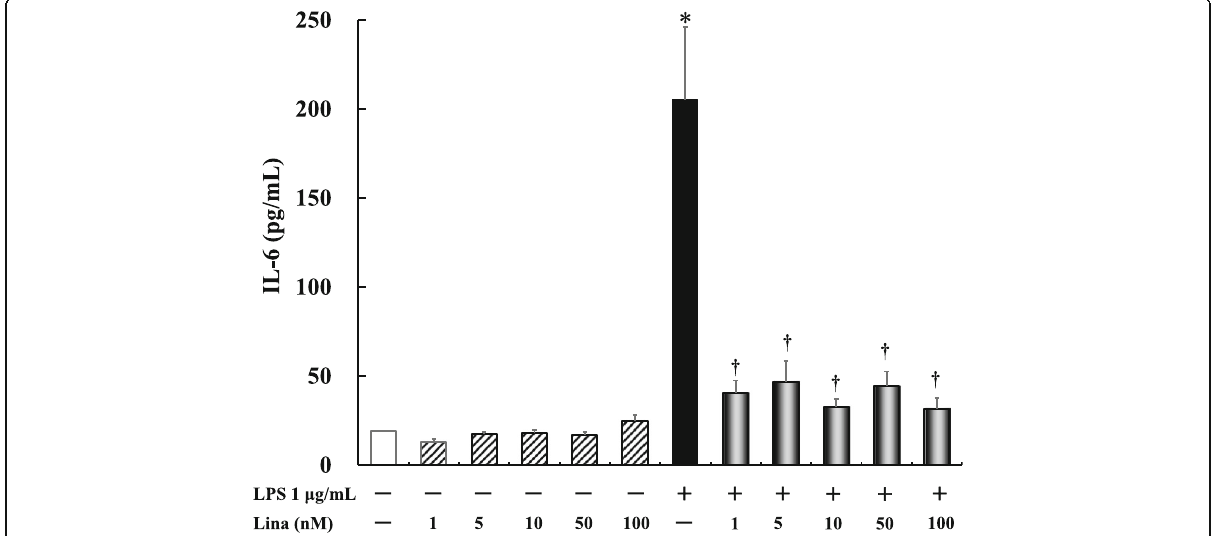
Fig. 1 Effects of linagliptin treatment on lipopolysaccharide (LPS)-induced interleukin (IL)-6 production after 24 h. Human U937 monocytes were treated with LPS and/or linagliptin. IL-6 levels in the supernatants were determined via enzyme-linked immunosorbent assay (ELISA) after 24 h of treatment. * P < 0.0001 vs. control; † P < 0.0001 vs. LPS 1 μ g/mL. Lina,